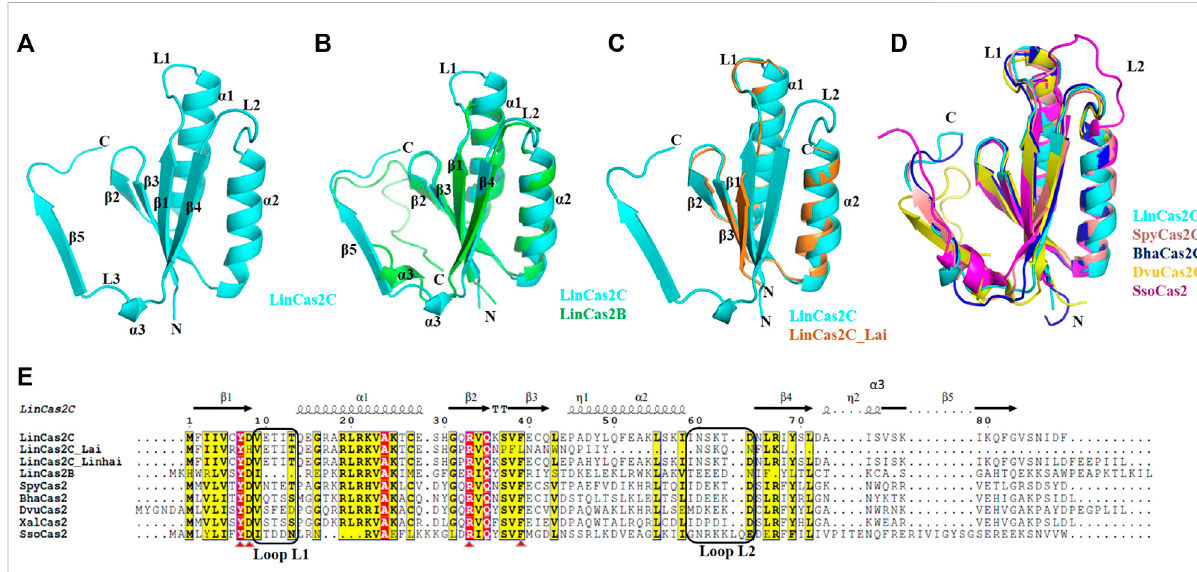
FIGURE 4 The crystal structure of rLinCas2C and its correlation with various orthologs. (A) The crystal structure of rLinCas2C is represented as a cartoon model. All the secondary structural elements, along with the N-and C-termini, are labeled for clarity. In order to map the putative substrate-binding loop (L1 and L2), rLinCas2C structure was correlated with LinCas2B; rmsd: 0.8 (B) LinCas2C_Lai; rmsd: 1.0 (C) , SpyCas2; rmsd: 0.9, BhaCas2; rmsd: 0.6, DvuCas2; rmsd: 0.9, SsoCas2; rmsd: 1.4 Å (D) . (E) Multiple sequence alignment of LinCas2C with its orthologs. Two putative substrate- binding loops, L1 (DNA) and L2(RNA), and secondary structure elements, are labeled. The secondary structuralelements on top ofthe alignment are given according to the rLinCas2C. XalCas2: Xanthomonas albilineans (D2UG58), BhaCas2: Bacillus halodurans (Q9KFX8), DvuCas2: Desulfovibrio vulgaris (Q72WF4), SsoCas2: Sulfolobus solfataricus (Q97YC2), SpyCas2: Streptococcus pyogenes (Q99YS8). Loop L1 and L2 are marked with rectangles. Red triangles highlight conserved